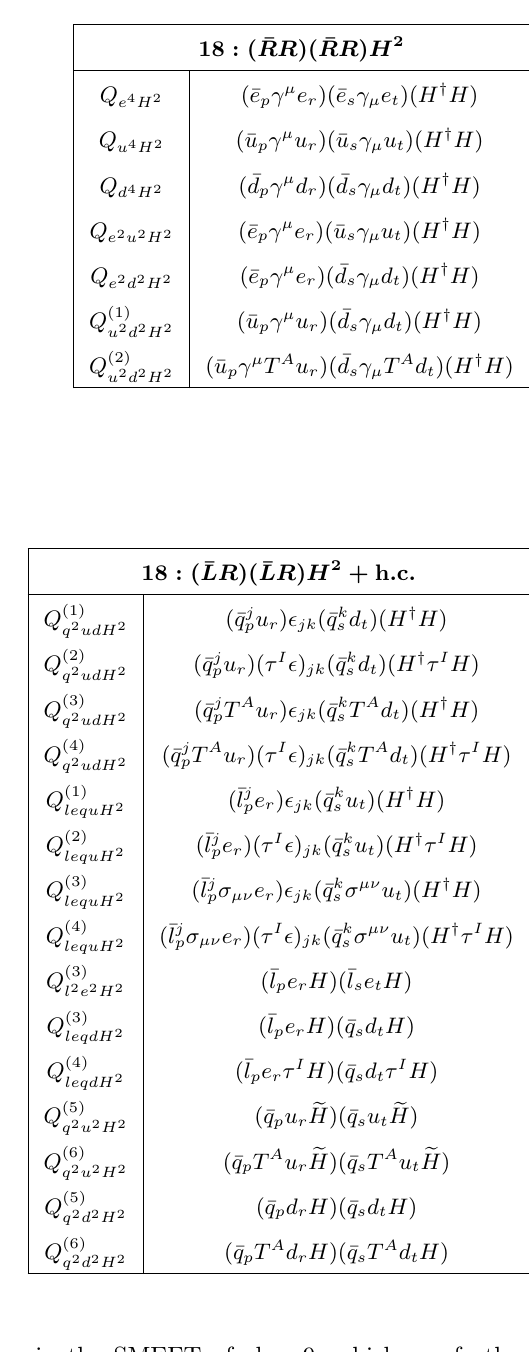
Table 11 . Most of the dimension-eight operators in the SMEFT of class-9, which are further divided into subclasses according to their chiral properties. See table 10 for the remaining class-9 operators. Operators with + h : c : have Hermitian conjugates. The subscripts p; r; s; t are weak- eigenstate